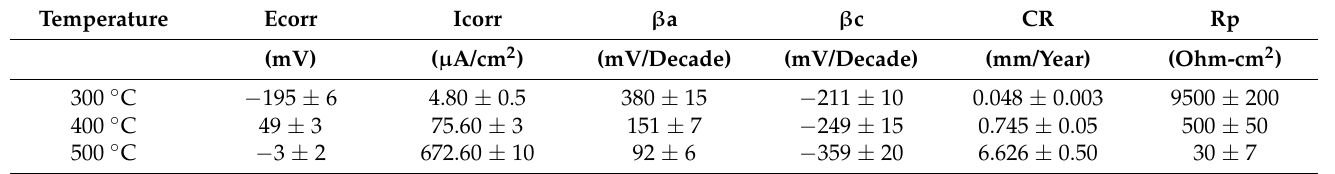
Table 2. Electrochemical parameters of Ni20Cr alloy immersed in ternary salt at different